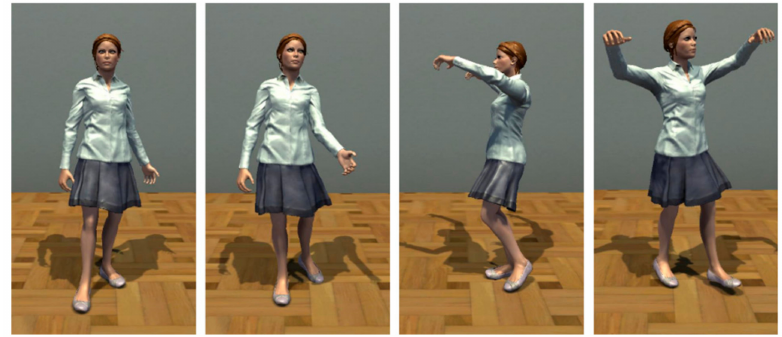
Figure 5. Dance animation of female avatar presented on projection screen.